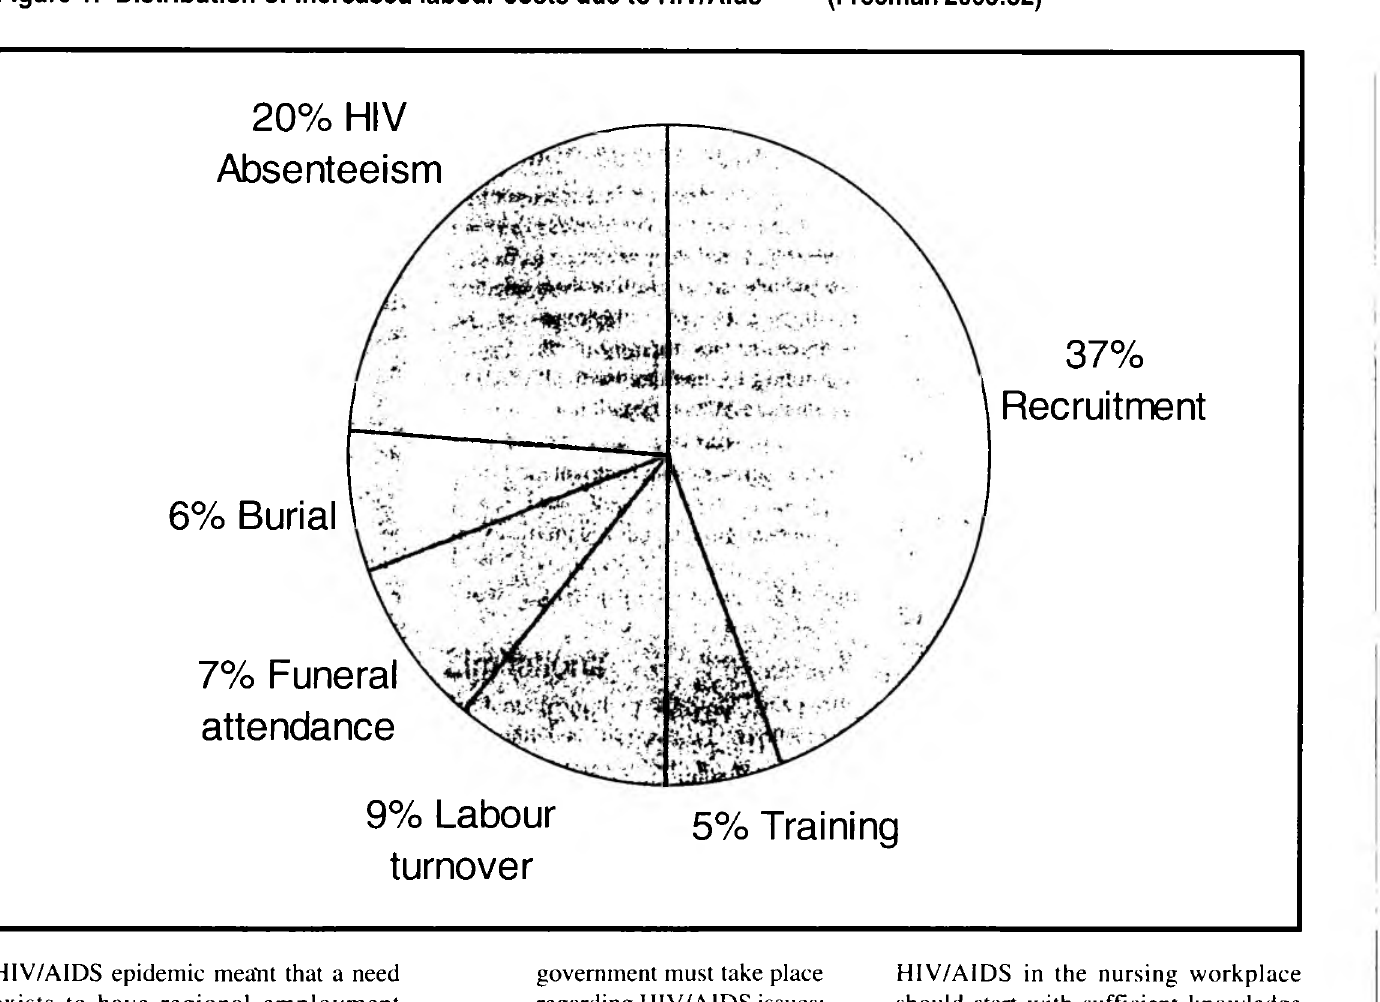
Figure 1: Distribution of increased labour costs due to